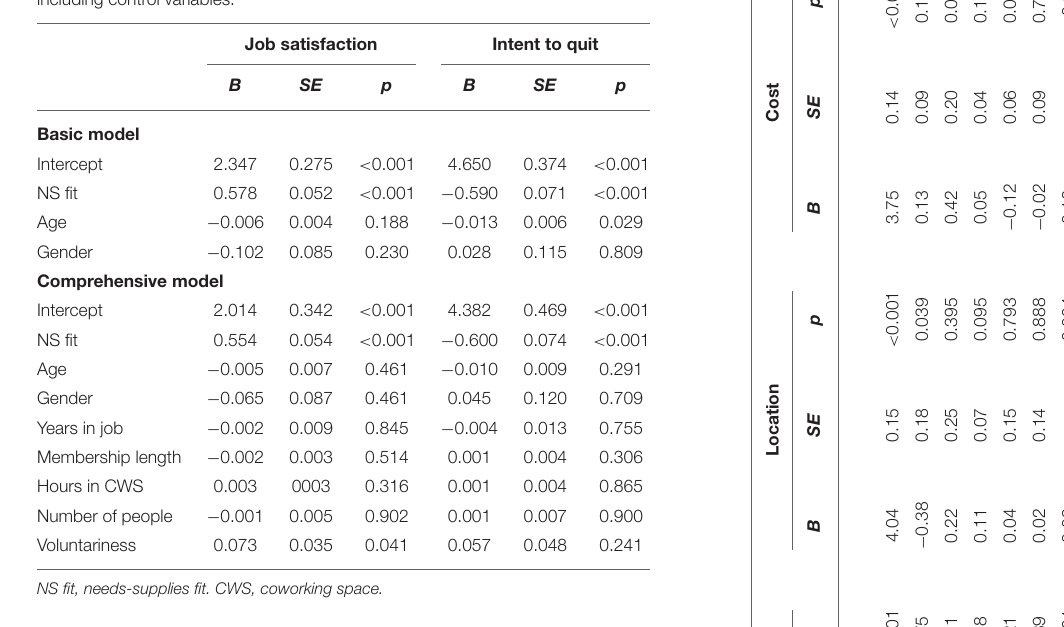
TABLE 2 | Regression analysis of NS fit on job satisfaction and intent to quit including control